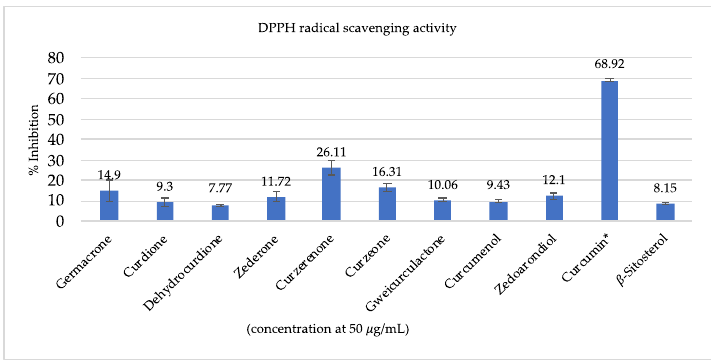
Figure 2. 2,2-Diphenyl-1-picrylhydrazyl (DPPH) radical scavenging activity of compounds isolated from C. aromatica , * = concentration of 25 μ g/mL.